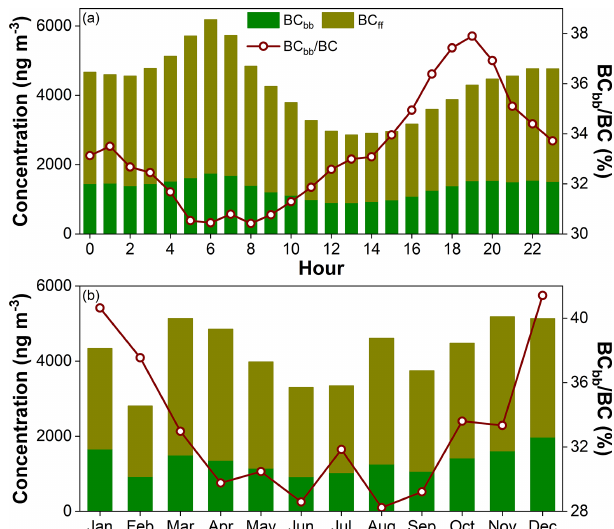
Figure 5. Diurnal and monthly variations in BC ff and BC bb con- centrations with the BC bb / BC